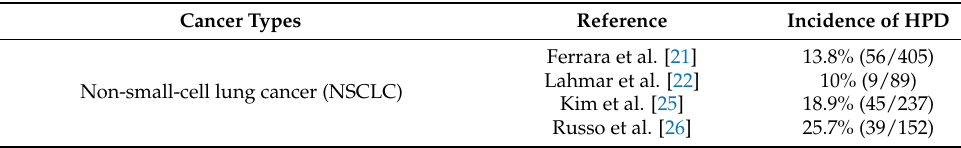
Table 2. The prevalence of HPD in various cancer